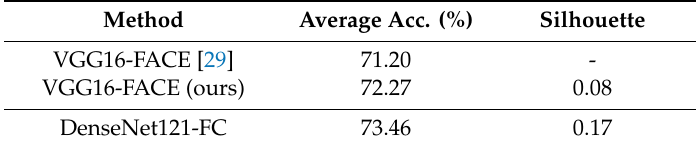
Table 1. Performance comparison of supervised learning for